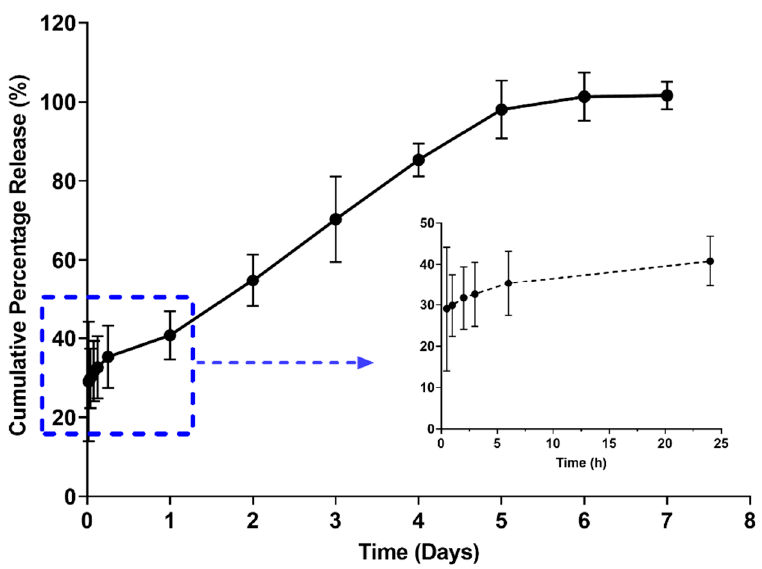
Figure 7. In vitro drug release profile demonstrating a sustain release over a period of 7 days with initial burst release as shown in insert (n = 3).